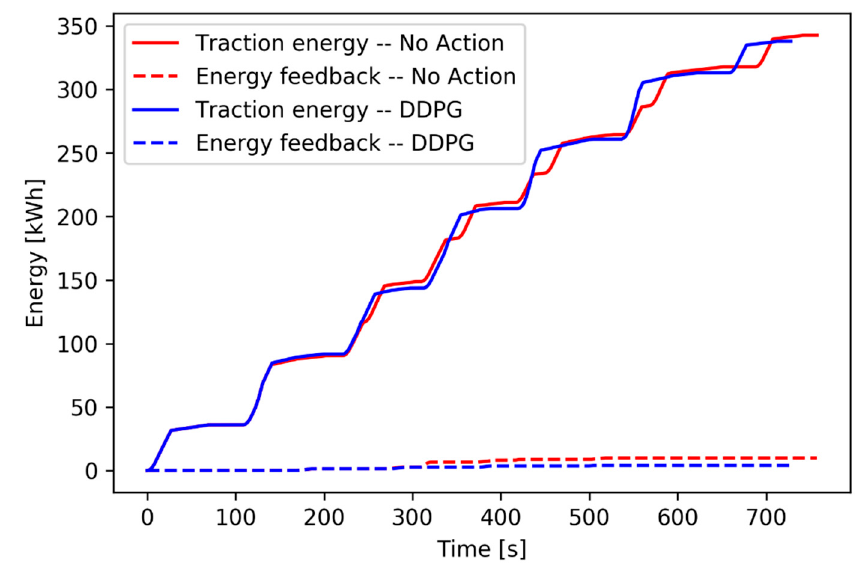
Figure 9. Energy accumulation under an 11 s delay.